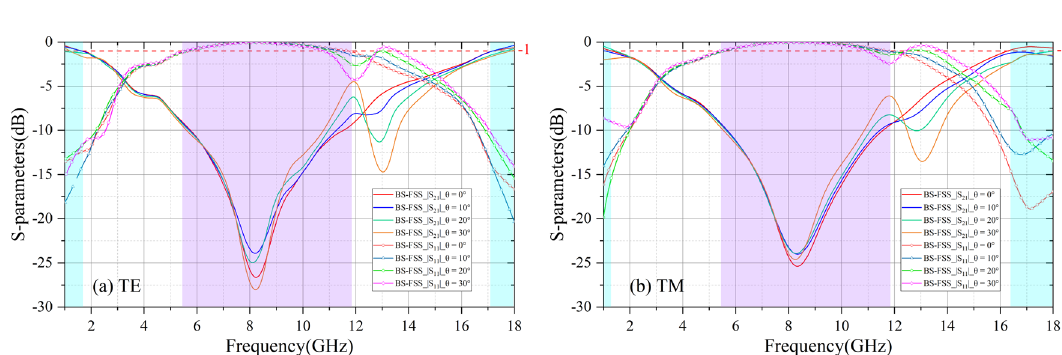
Figure 12. Measurement results of the proposed BS-FSS Prototype: ( a ) At TE-polarization, reflection/ transmission coefficients under different oblique incidences. ( b ) At TM-polarization, reflection/transmission coefficients under different oblique